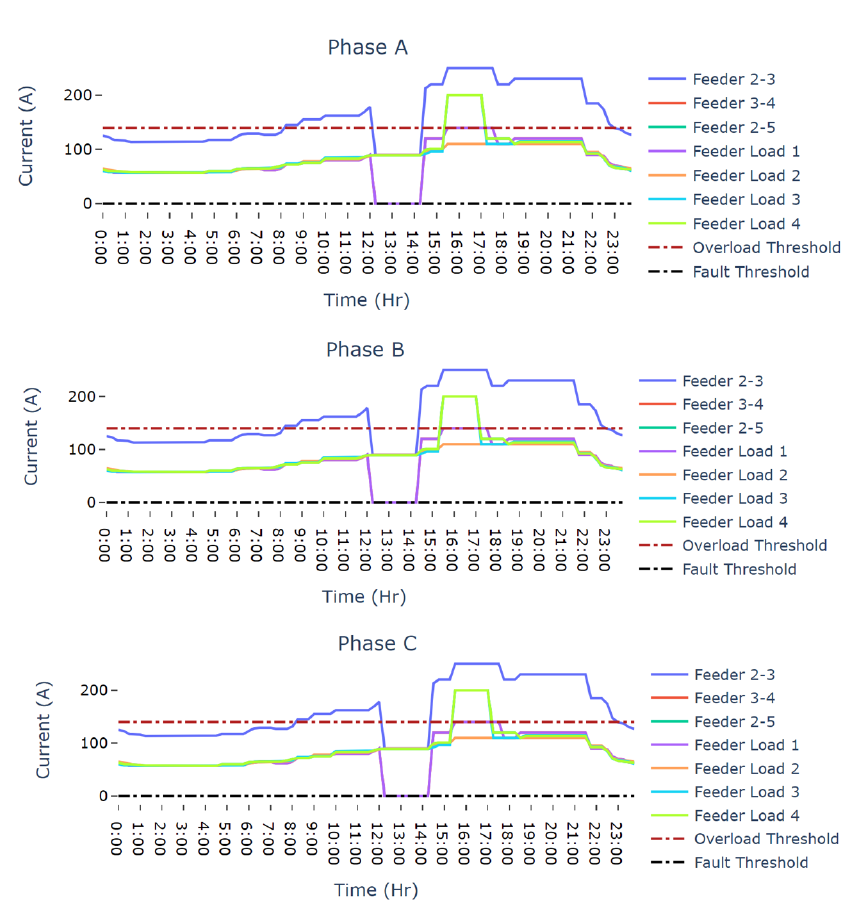
Figure 6. Graph visualizations of feeder current values on mobile